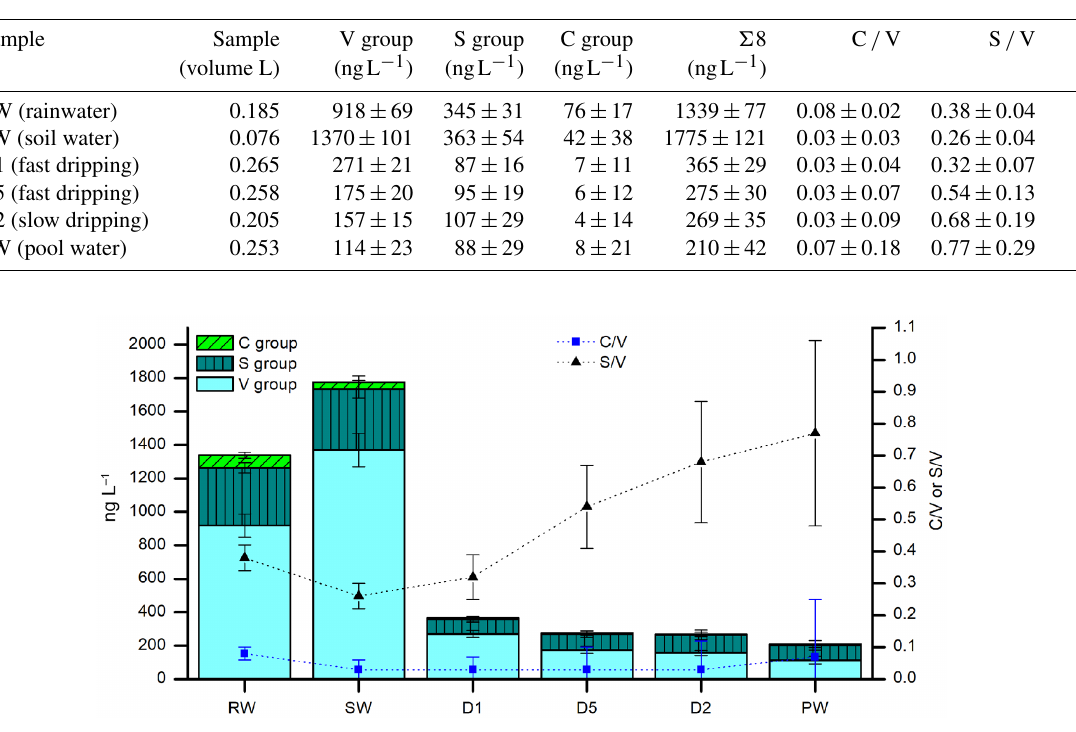
Figure 8. LOP concentrations (stacked columns with left axis) and LOP ratios (symbols with right axis) of rainwater (RW), soil water (SW), cave drip water from fast drip sites (D1 and D5) and a slow drip site (D2), and cave pool water (PW). The stacked columns contain the V-group LOPs (light cyan bars), S-group LOPs (dark cyan bars with vertical stripes), and C-group LOPs (green bars with diagonal stripes). Black triangles show the S / V ratio and blue squares show the C / V